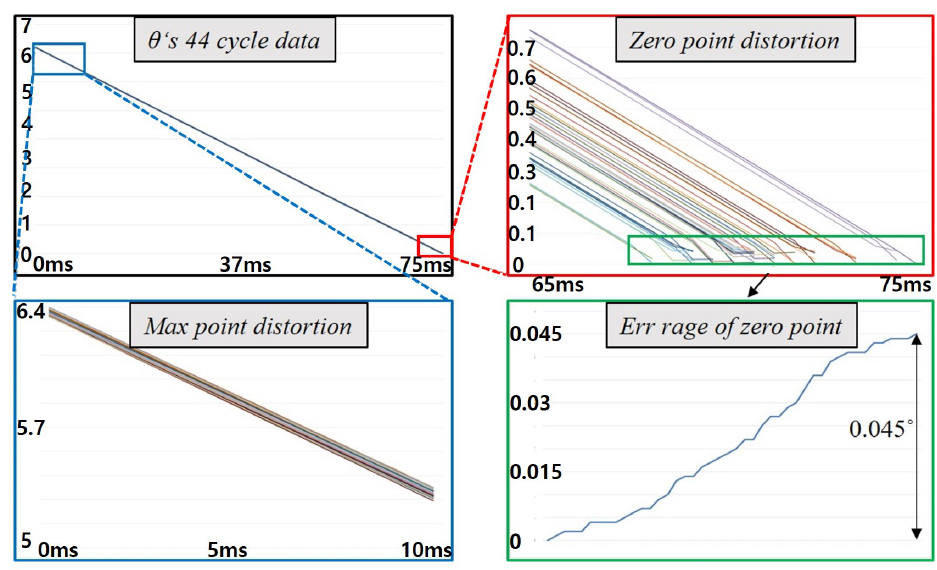
Figure 9. θ e ’s data 44 cycle using tan − 1 method.